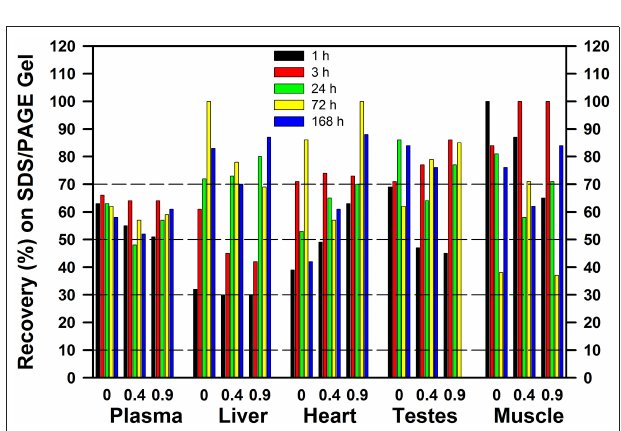
FIGURE 10 | Recovery of 75 Se from [ 75 Se]SeMet as 75 Se-labeled selenoproteins on SDS/PAGE gels. Rats were supplemented with 0.2 µ g Se/g diet as selenite in the basal diet containing 0.4% supplemental Met for 50–80 d. For 7 days prior to Se injection, supplemental Met was adjusted to 0, 0.4, or 0.9% D,L-Met; rats were then injected iv with 50 µ Ci of [ 75 Se]SeMet,and tissues were subjected to SDS/PAGE as described for Figures 2 – 6 ( n = 15 total rats). Values are the percent of the applied 75 Se recovered in the gel after SDS/PAGE in the indicated tissues at the indicated times.